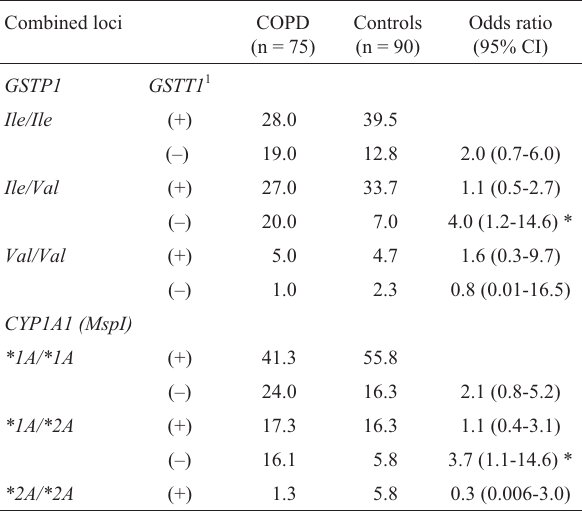
Table 4 - Combined loci effects comparing patients with chronic obstructive pulmonary disease (COPD) and controls (%). Combined